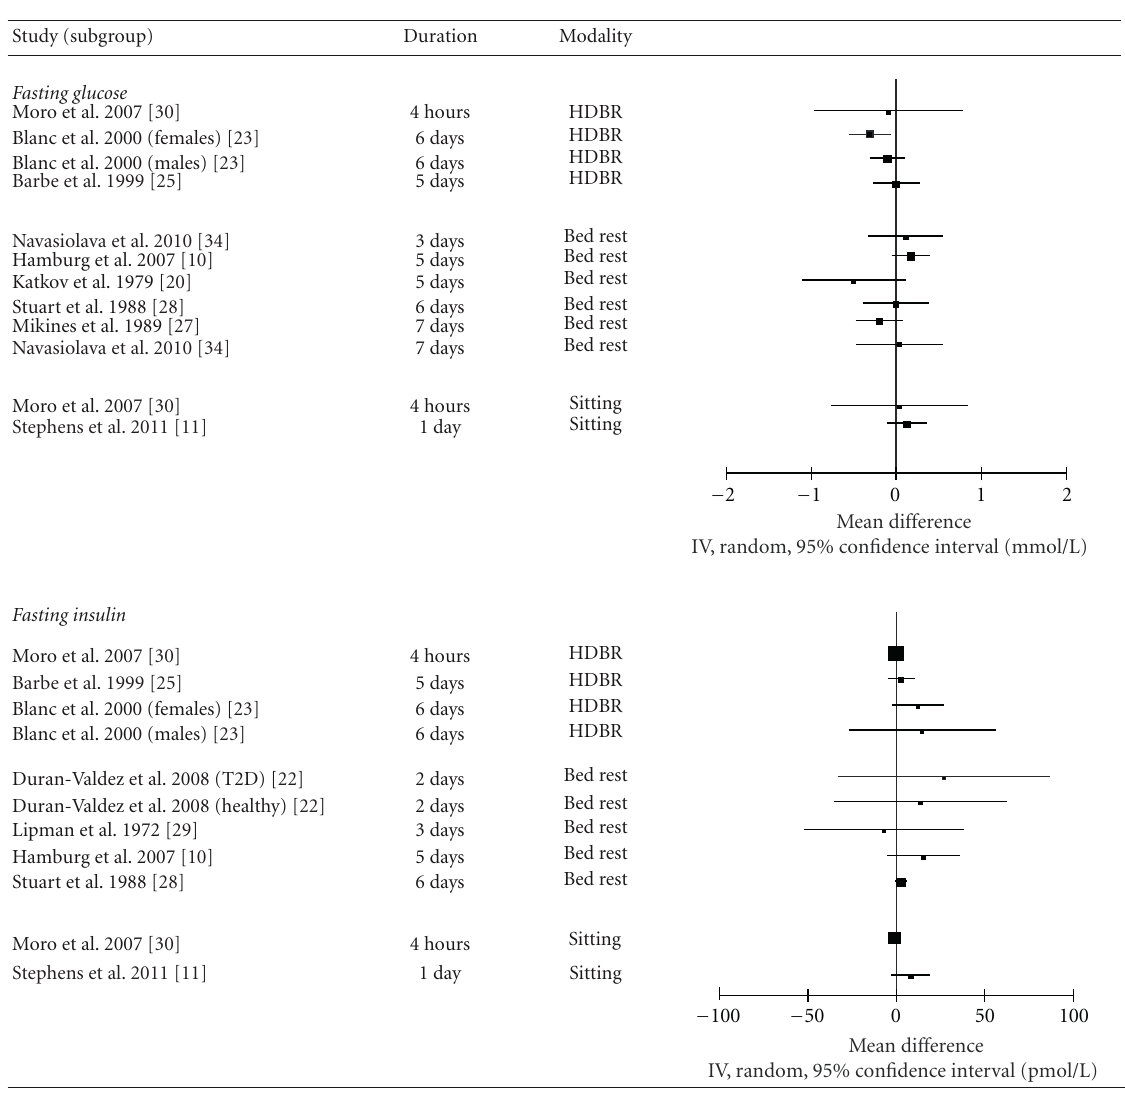
Figure 2: Forest plot of mean di ff erences of fasting glucose and insulin values between sedentary behaviour and control conditions (sedentary